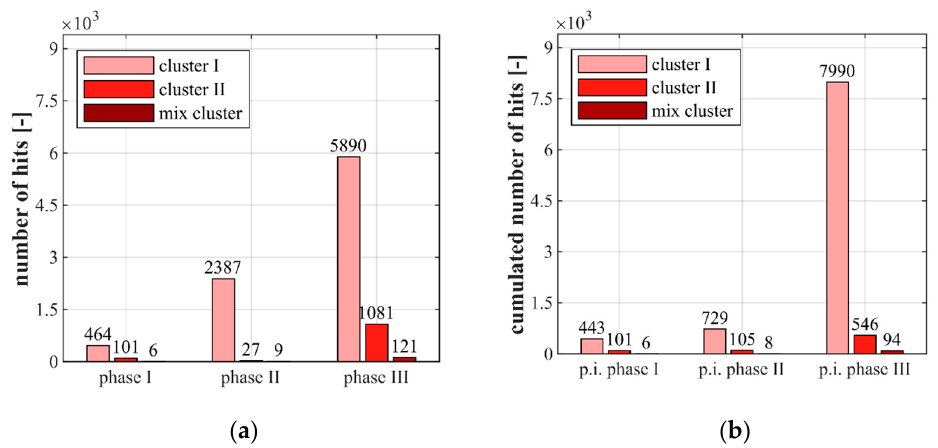
Figure 8. Clusters of AE-hits displayed for the entire duration of each phase ( a ) and displayed as cumulated AE-hits (i.e., including the hits from previous phases) up to the points of interruption (p.i.) ( b ) for S c,max = 0.70.